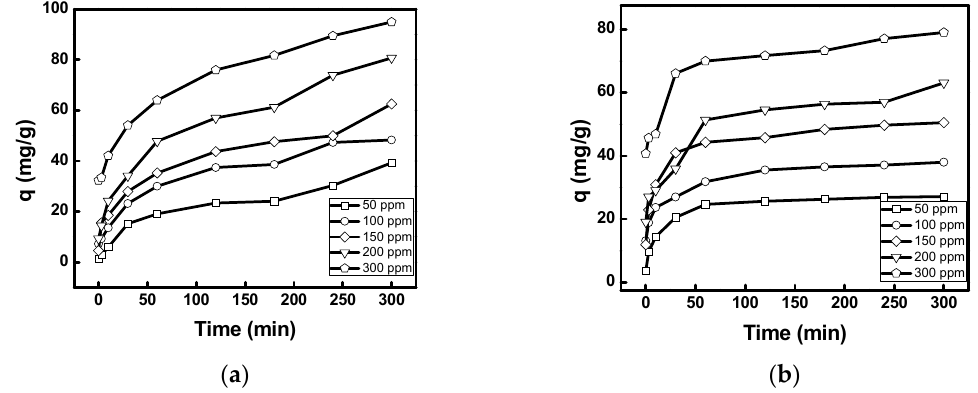
Figure 3. Effect of contact time on the adsorption capacity at 25 °C on ( a ) AC and ( b ) MAC. Figure 3. E ff ect of contact time on the adsorption capacity at 25 ◦ C on ( a ) AC and ( b )